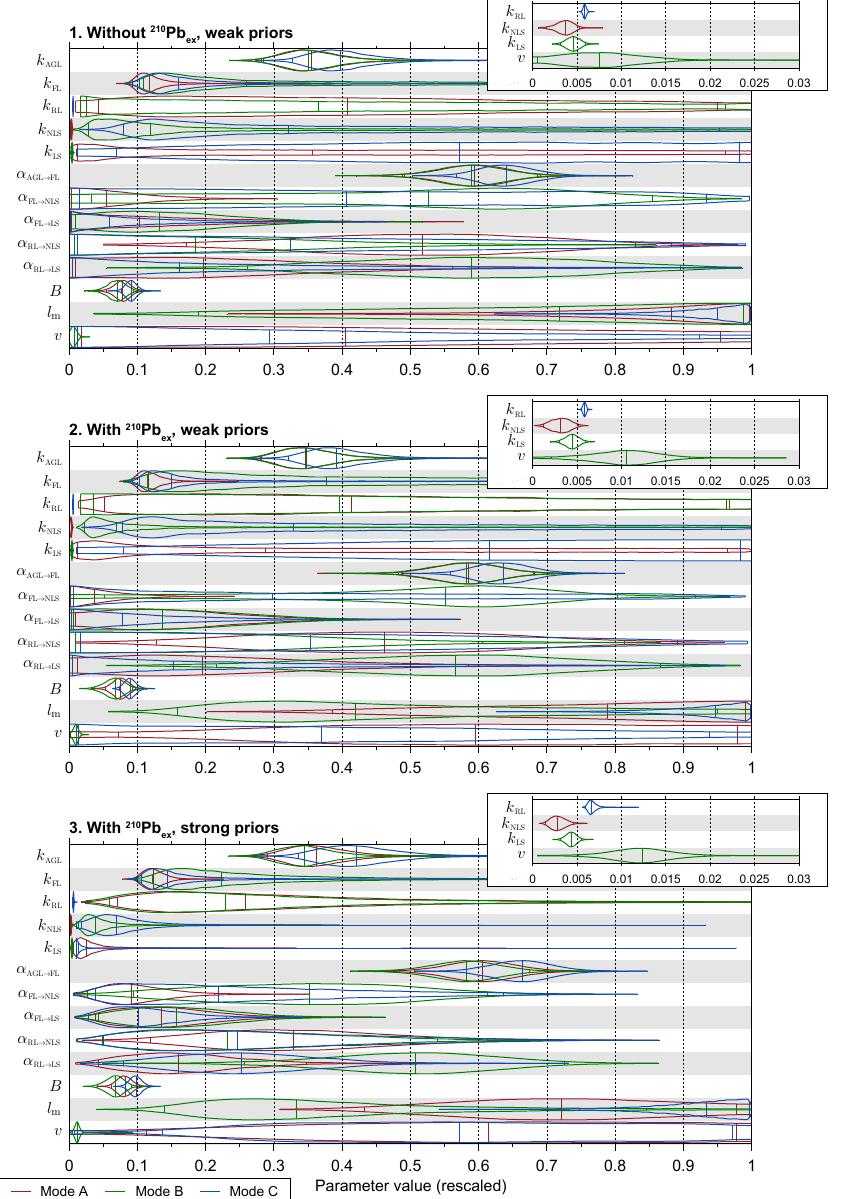
Fig. 7. Posterior distributions for the three calibration setups for Hainich. The “violins” depict the marginal distribution for each parameter. The three posterior modes are plotted separately in the same graph. The three vertical lines inside the violins indicate the median and the 95 % confidence bounds. The parameters are normalized to the sampling ranges (see Table 2).